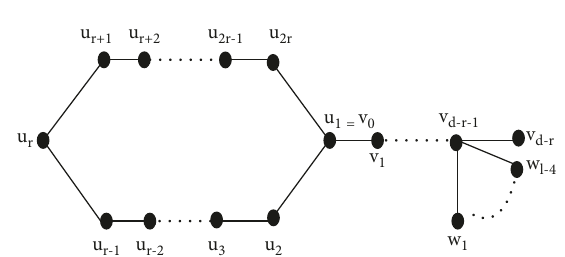
Figure 8: A graph with radius r , diameter d , and sm